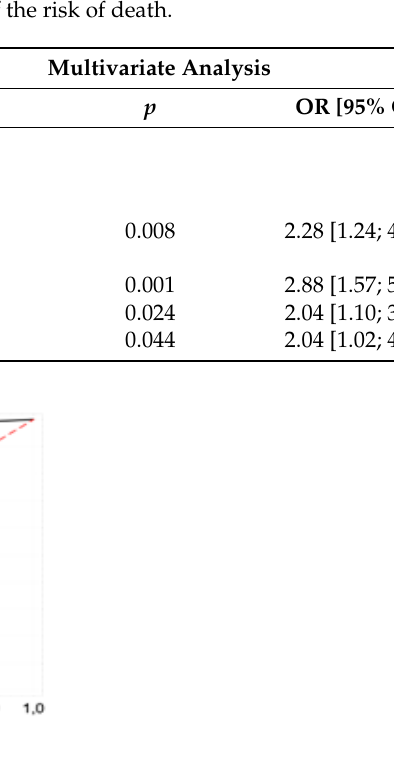
Figure 2. ROC curves for estimating in-hospital deaths based on blood counts and area under the curves (AUC) and their 95% confidence, sensitivity and specificity intervals for the threshold values proposed from the maximum Youden index. Table 4. Results of the logistic regression analysis of the risk of death.